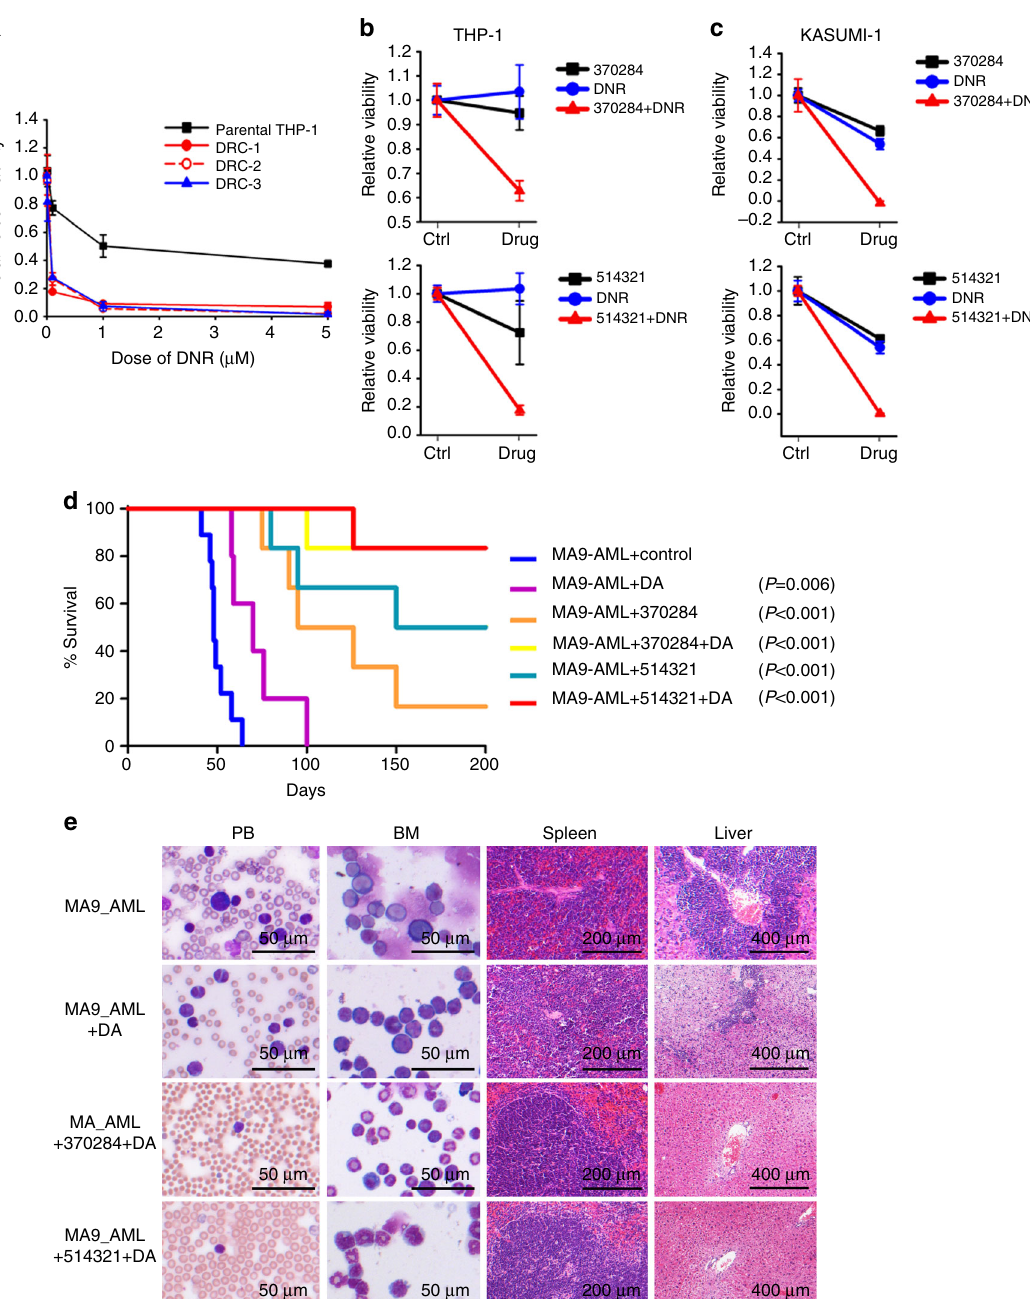
Fig. 6 Synergistic effect of NSC-370284 or UC-514321 with daunorubicin in treating TET1 -high AMLs in vitro and in vivo. a NSC-370284-resistant AML cells are sensitive to DNR. Three of the THP-1 NSC-370284-resistant clones (DRC-1 – 3) and the parental control were treated with DNR at indicated doses. Cell viability was tested 48 h after the treatments. b , c THP-1 ( b ), and Kasumi-1 ( c ), cells were treated with DMSO (Ctrl), 25 nM NSC-370284 (upper panels) or UC-514321 (lower panels), and/or 100 nM DNR. Relative cell viability at 48 h post drug treatment is shown. Error bar indicates SD of triplicate experiments. d Synergistic therapy of NSC-370284 or UC-514321 in combination with standard chemotherapy. Secondary BMT recipient mice were transplanted with primary MLL-AF9 leukemic BM cells. Upon the onset of leukemia, the mice were treated with DMSO (control), “ 5+3 ” regimen 48 alone (i.e., a daily dose of 50 mg/kg Ara-C for fi ve days along with a daily dose of 3 mg/kg DNR during the fi rst three days of Ara-C treatment), or in combination with 10 days ’ NSC-370284 or UC-514321 treatment, 2.5 mg/kg, i.p., once per day. Five to nine mice were included in each group. Kaplan – Meier curves are shown. The P values were determined by log-rank test. e Wright – Giemsa staining of mouse PB and BM, or H&E staining of mouse spleen and liver of MLL-AF9 secondary BMT recipients treated with “ 5+3 ” alone, or combinational